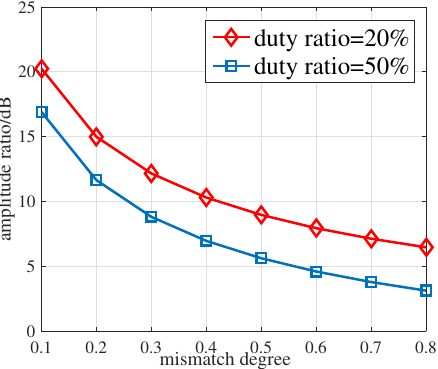
Figure 6. Amplitude ratio of − 1 order false target to real target after cancellation for Method